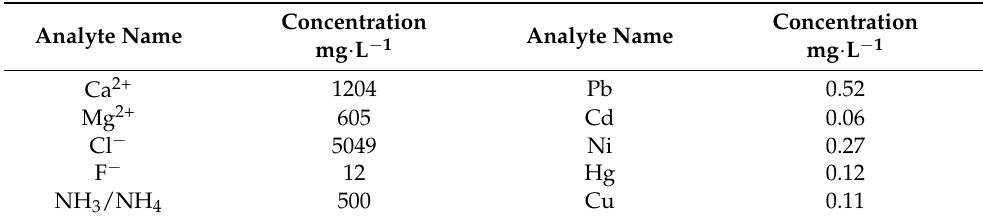
Table 1. Analysis of desulfurization wastewater